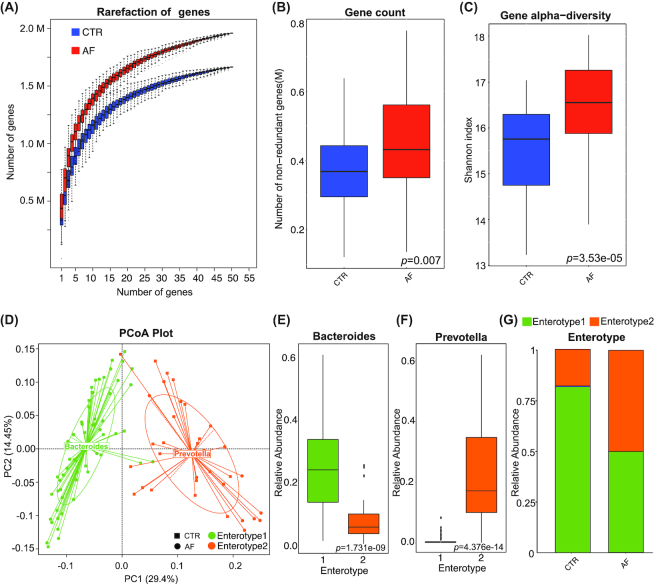
Elevated microbiota richness and altered community types in patients with AF. A, Rarefaction curves for gene number, which were calculated after 50 iterations of random sampling with replacement in control (CTR; n=50) and AF (n=50). X-axis is the number of samples and Y-axis means number of genes. The rarefaction curve is near smooth when the sequencing data are great enough with few new genes undetected and the present sample size has met the need of this study. B and C, Gene count (B) and α-diversity (Shannon index) (C) based on the genera profile in the AF and control cohorts. Boxes represent the interquartile ranges, and lines inside the boxes denote medians. Gut microbial richness (gene count) and diversity in the AF group were much higher (P=0.007, control vs AF, for gene count; P=3.53e−05, control vs AF, for α-diversity; Kruskal-Wallis test). D, 100 samples are clustered into enterotype 1 (green) and enterotype 2 (orange) by principal component analysis (PCA) of Jensen-Shannon divergence values at the genus level. The major contributor in the 2 enterotypes is Bacteroides and Prevotella, respectively. E and F, Relative abundances of the top genera in each enterotype, Bacteroides in enterotype 1 (E), Prevotella in enterotype 2 (F). Boxes represent the interquartile ranges, lines inside the boxes denote medians, and circles are outliers. P=1.731e−09 and P=4.376e−14, respectively; Wilcoxon rank sum test. G, The percentage of control and AF samples distributed in enterotype 1 and enterotype 2. A dysbiosis of enterotype distribution by AF conditions was revealed. There were 50% controls in enterotype 1, 50% controls in enterotype 2; 82% AF participants in enterotype 1, 18% AF participants in enterotype 2. P=0.001, control vs AF; Fisher's exact test, PCoA: principal coordinate analysis.